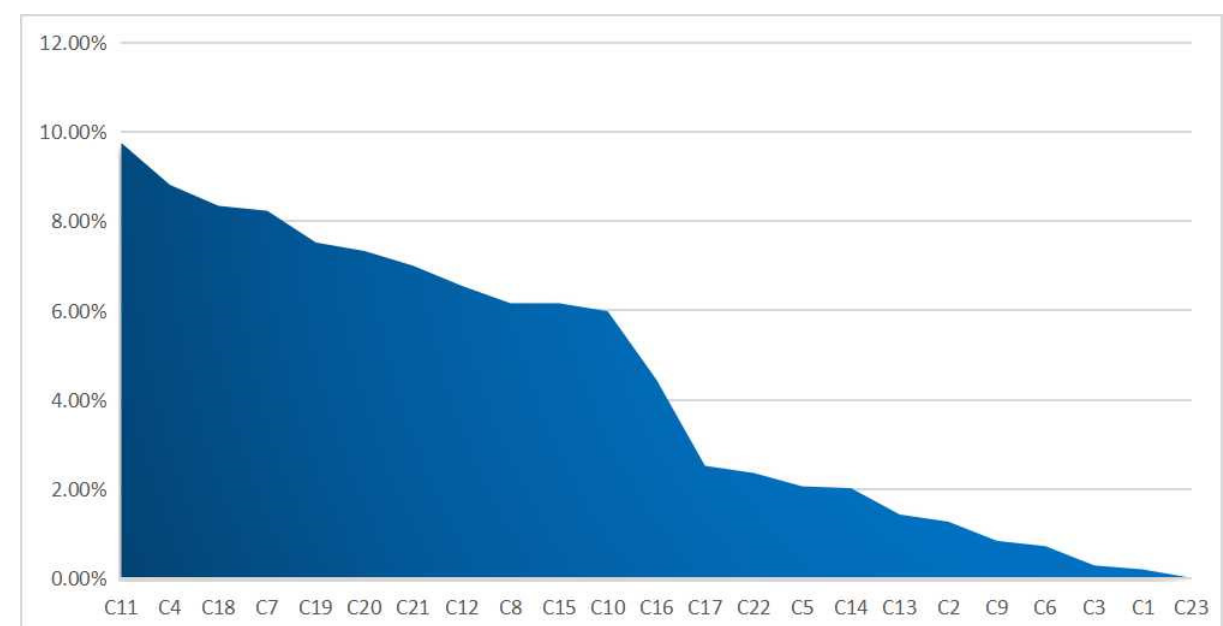
Figure 3. Diagram of the obstacle level of green development.